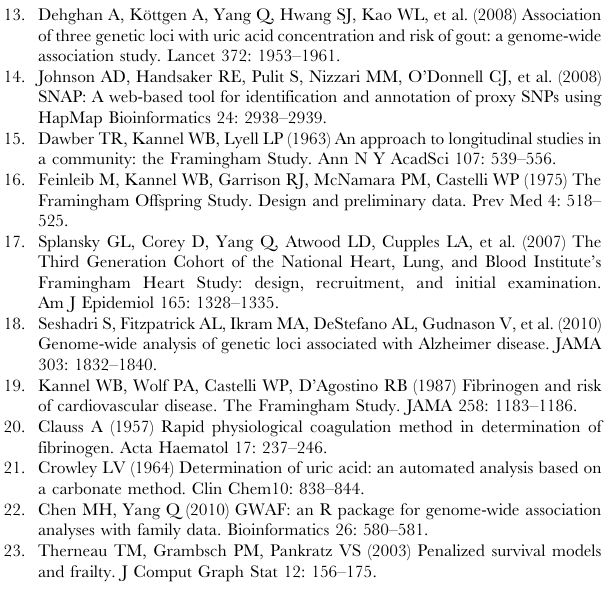
Figure S5 Regional association plot of rs4420638 for Alzheimer disease using incorporated genotype data. (TIFF) Figure S6 Regional association plot of rs4681 for Fibrinogen using incorporated genotype data. (TIFF) Figure S7 Regional association plot of rs3764261 for HDL using incorporated genotype data. (TIF) Figure S8 Regional association plot of rs1919484 for HDL using incorporated genotype data. (TIF) Figure S9 Regional association plot of rs10186236 for HDL using incorporated genotype data. (TIF) Figure S10 Regional association plot of rs1800588 for HDL using incorporated genotype data. (TIF) Figure S11 Regional association plot of rs16890979 for uric acid using incorporated genotype data. (TIF) Figure S12 Regional association plot of rs2231142 for uric acid using incorporated genotype data. (TIF) Figure S13 Regional association plot of rs1165205 for uric acid using incorporated genotype data.